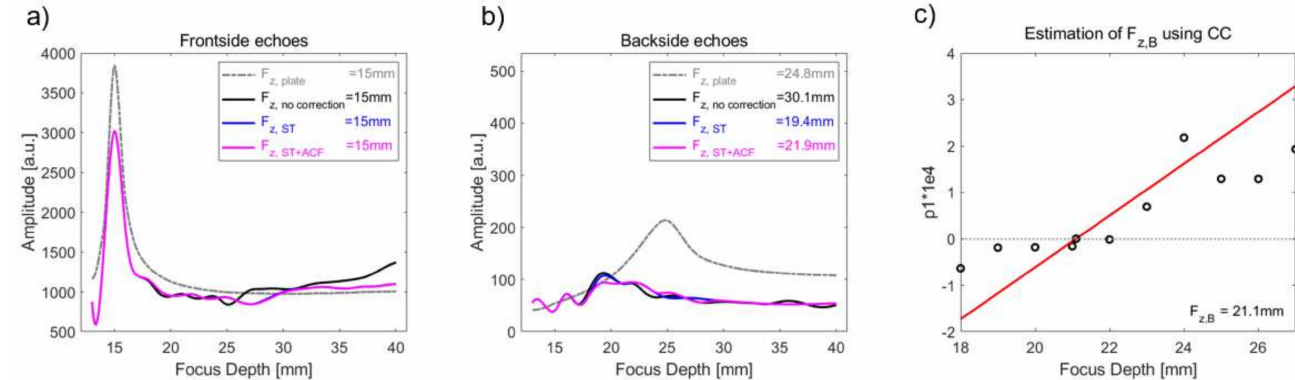
Figure A4. Model r40dx5.11 : ( a ) Comparison of tracked amplitude at each correction step for frontside amplitudes (tracked amplitude after ST, ST + ACF and ST + ACF + CC correction overlap). The reference- tracked amplitude of the plate model was shown by the grey dashed line ( b ) and backside amplitudes (tracked amplitude after ST and ST + ACF correction overlap), respectively. ( c ) Curvature parameter p 1 , retrieved from second order fit of using CC, as a function of focal depth (black circles). Linear fit (red line) was used to retrieve F z,B at zero-crossing point. ( d ) Comparison of focus shift ∆ F z and shift (black crosses) in time-of-flight ∆ TOF (grey circles) to the reference ∆ F zRef (dashed black line) and ∆ TOF Ref (dashed grey line) of the plate model. ( e ) Estimated Ct . Th MF and Ct. ν 11 MF after each correction step compared to the reference Ct . Th Ref (dashed black line) and Ct . ν 11 Ref (dashed grey line) value.